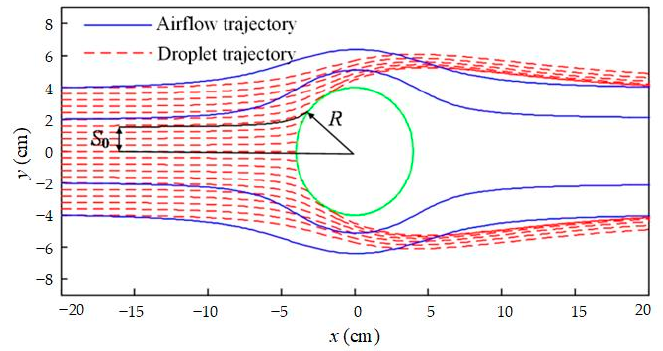
Figure 1. The trajectories of water drops and airflow around the conductor.